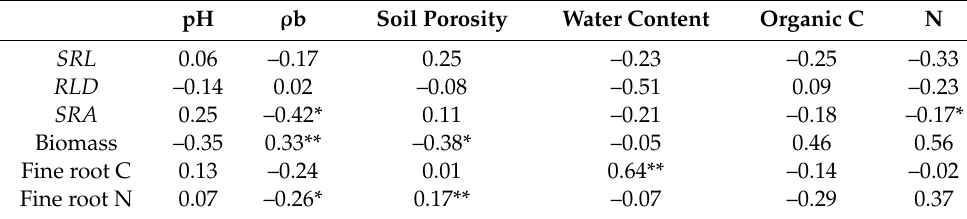
Table 6. Correlation coe ffi cients between fine root and soil